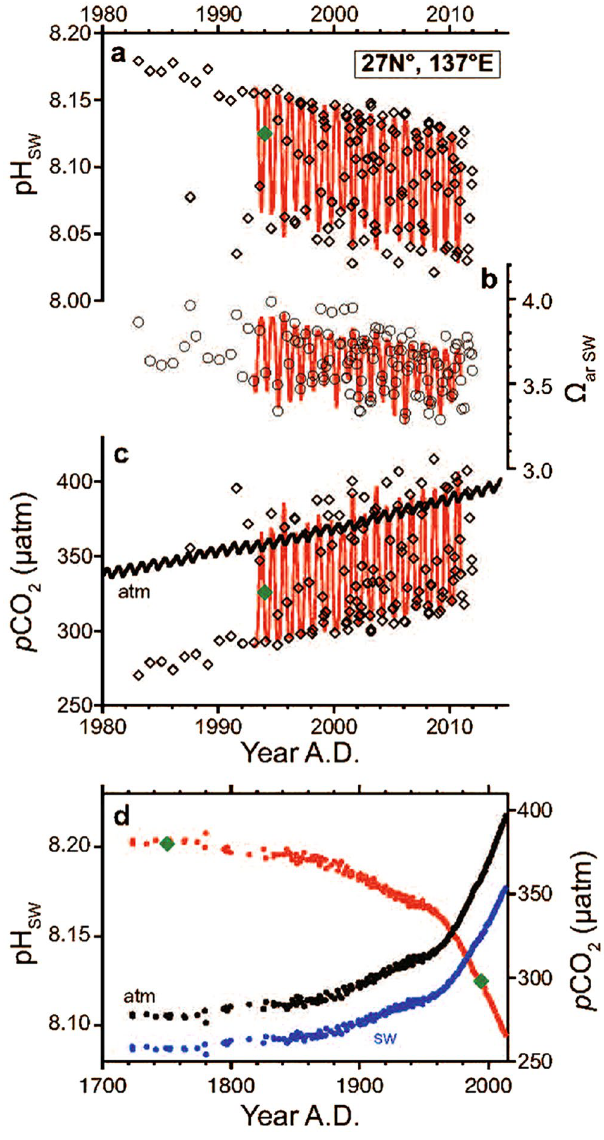
Figure 2. pH SW and p CO 2 variability. ( a – c ) Time series (lines) and discrete data (open symbols) for pH SW , Ω arSW , and p CO 2 in the western North Pacific near Chichijima and Kikaijima since 1980 at monthly resolution. Monthly atmospheric p CO 2 records measured at the MLO 17 are also shown in ( c) . ( d ) Variability in pH SW (red) and p CO 2 (blue, seawater; black, atmosphere) since the preindustrial era. Atmospheric p CO 2 in 1959–2013 was measured at the MLO 17 and atmospheric p CO 2 before 1959 was reconstructed from trapped air in the Antarctic ice sheet 18 . pH SW calculated from Global Data Analysis Project DIC and TA for the years 1994 and 1750 (ref. 3) are indicated by the green diamonds in ( a and d